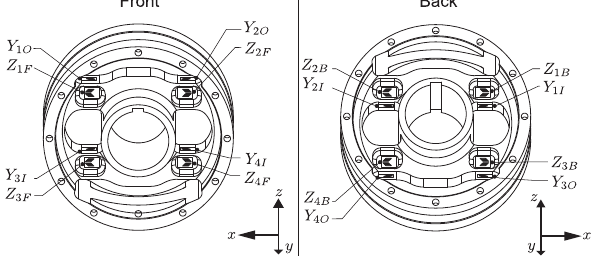
Figure 5. Deformation element with strain gauges.